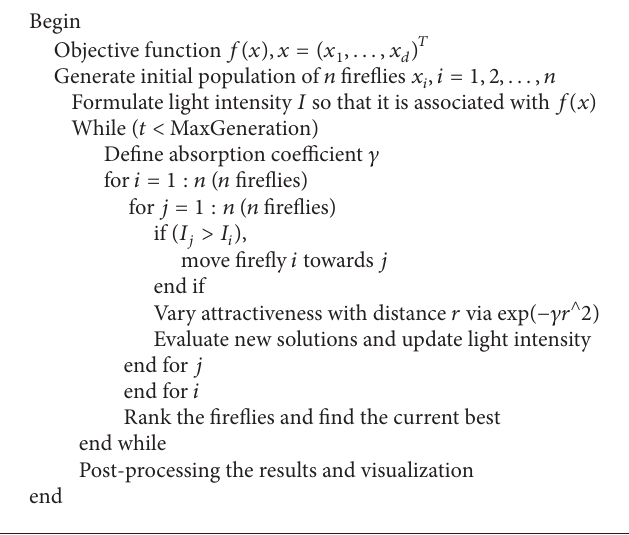
Pseudocode 1: Pseudocode of the